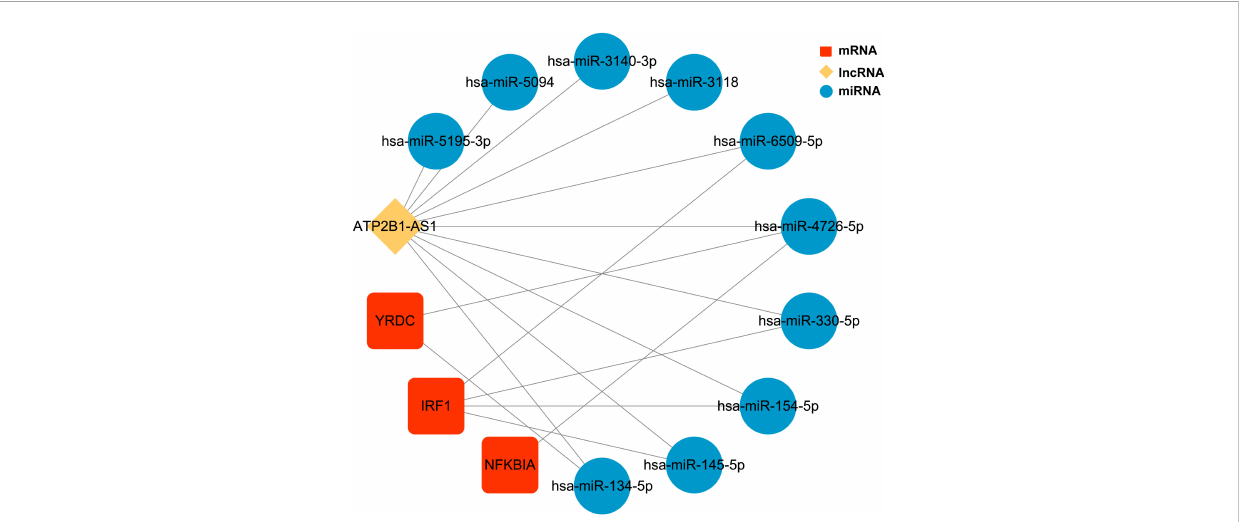
FIGURE 7 The ceRNA regulatory network of three biomarkers CeRNA network. Red rectangles represent three biomarkers, the yellow diamond represents the lncRNA, and blue circles represent the miRNAs.